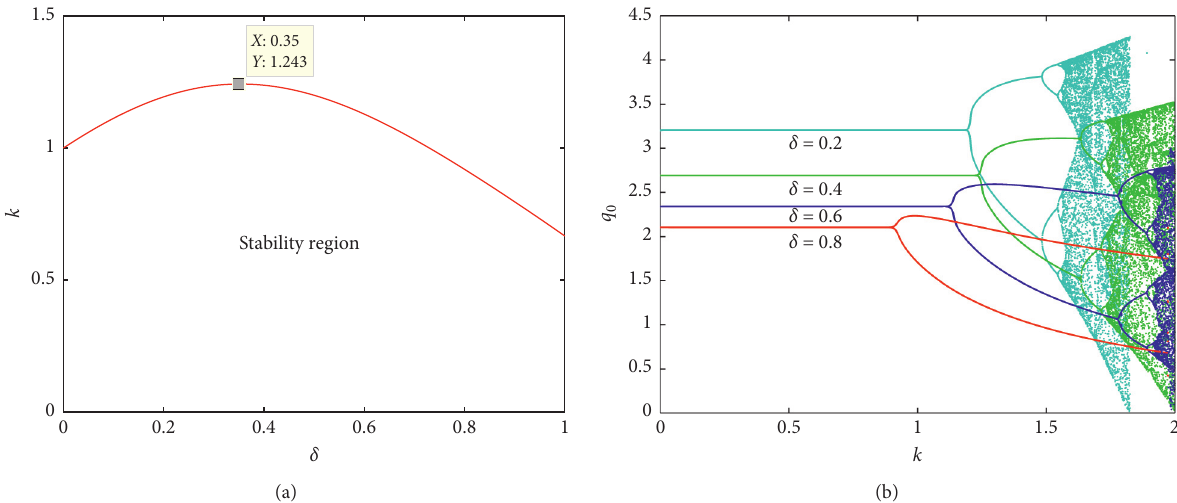
Figure 1: (a) The stability regions in the c -plane of Nash equilibrium point E respect to the parameter k with the variable q